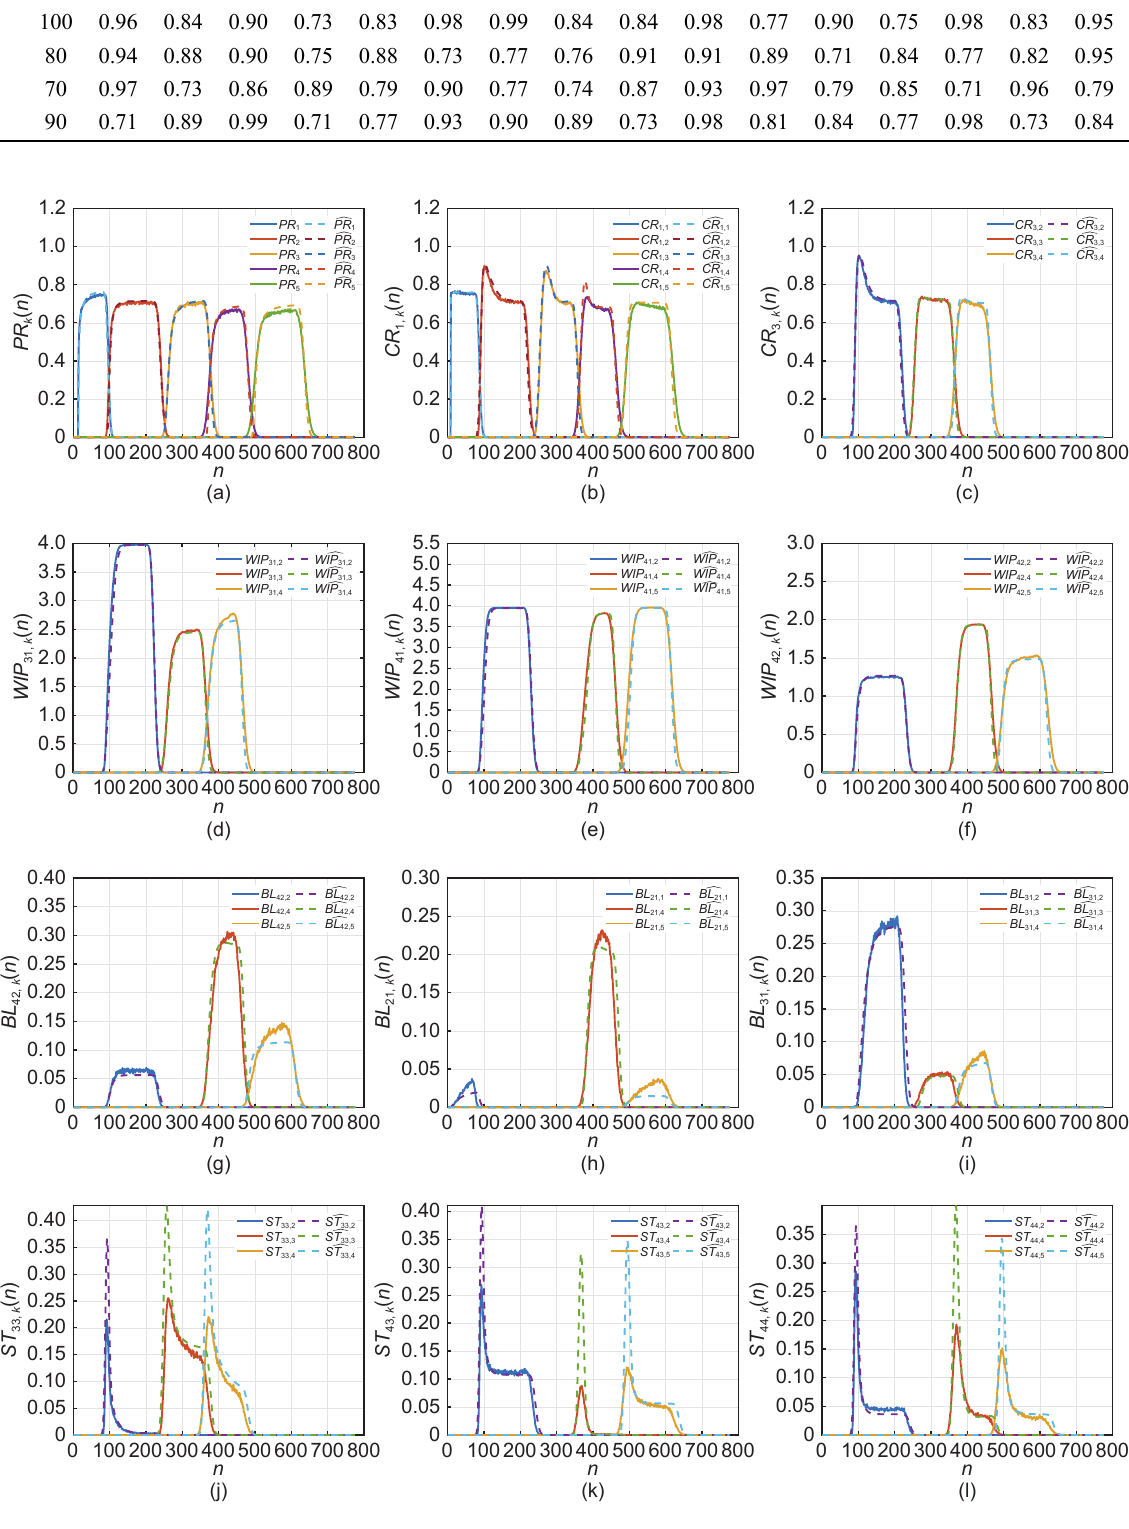
Fig. 9 Comparison of simulation and approximation methods for dynamic performance